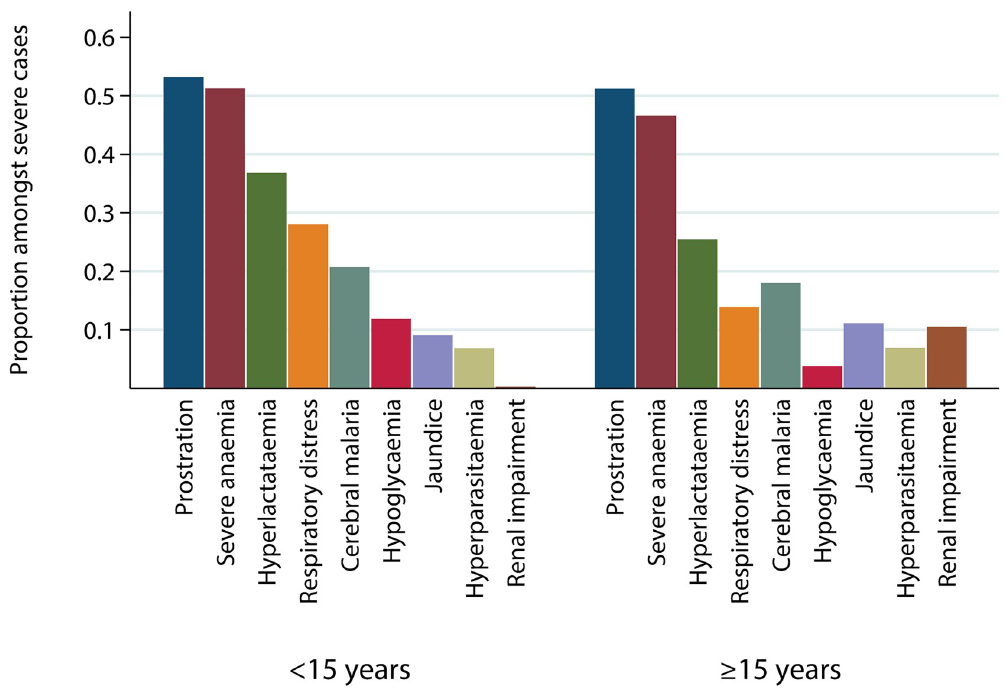
Fig 1. Prevalence of SM phenotypes amongst severe cases by age group. Proportions were calculated for severe cases with no missing values for a given measure. Information for all phenotypes was not available in all studies (Table 1, S2 and S4 Tables). Each case can present with more than 1 phenotype. SM, severe